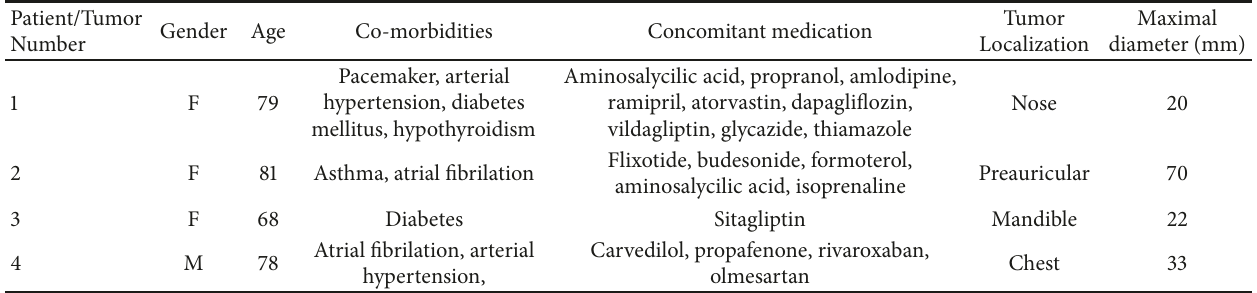
Table 1: Patients, tumors, and treatment characteristics. Patients 1 and 3 required half a tube per application of the commercially available ingenol mebutate gel (Picato (cid:2) Gel, 500MCG/G), while patients 2 and 4 applied the whole tube per